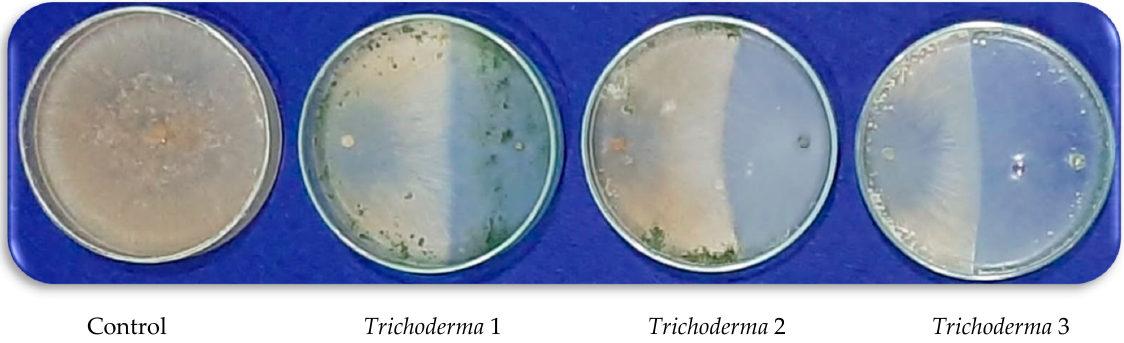
Figure 3. Antagonism of three isolates of Trichoderma spp. on Rhizoctonia solani in in vitro experi- ment .